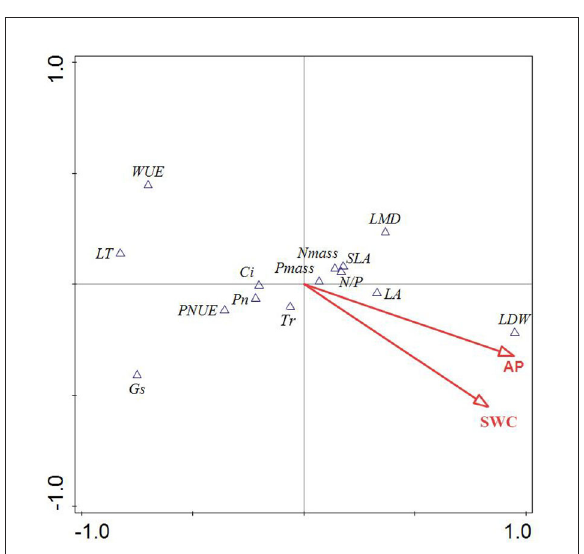
FIGURE4 CCA sequence of leaf functional properties and environmental factors in the water level fluctuation zone of Three Gorges Reservoir. Because SWC and AP have the highest explanatory degree for leaf functional traits of plants, only SWC and AP are selected for the diagram to highlight the differences explicitly. LT, leaf thickness; LDW, leaf dry weight; LA, leaf area; Pn, net photosynthetic rate; Gs, stomatal conductance; Tr, transpiration rate; Ci, intercellular CO 2 concentration; SLA, specific leaf area; LMD, leaf mass density; WUE, water use efficiency; Nmass, leaf total nitrogen; Pmass, leaf total phosphorus; N/P, leaf total nitrogen to leaf total phosphorus ratio; PNUE, photosynthetic nitrogen use efficiency; AP, soil available phosphorus; SWC, soil water